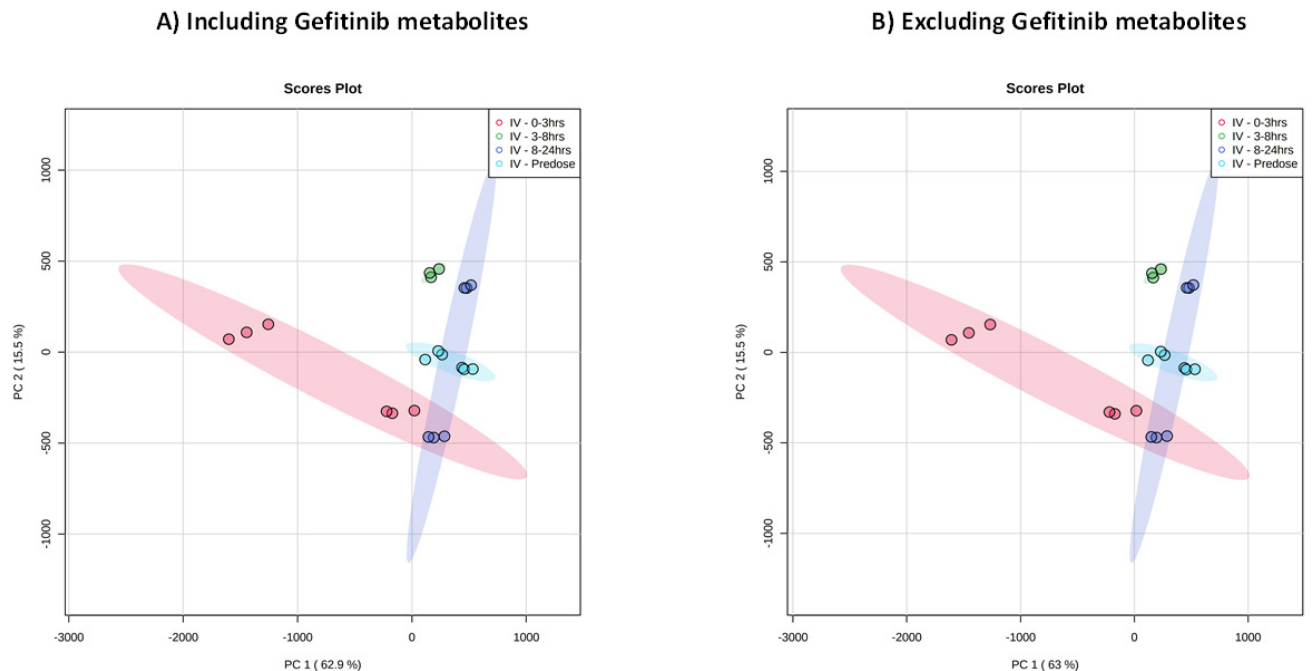
Figure 1. PCA of positive ESI LC–IM–MS data for urine obtained from male C57Bl6 mice dosed intravenously with 10 mg/kg gefitinib for the periods of pre-dose (light blue) and 0–3 (red), 3–8 (green), and 8–24 h (dark blue). These data were obtained following analysis (each urine pool in triplicate) with ( A ) MS data for gefitinib and metabolites included and ( B ) with MS data for gefitinib and metabolites removed, demonstrating the lack of any contribution to the separation as a result of drug-related material in the urine.